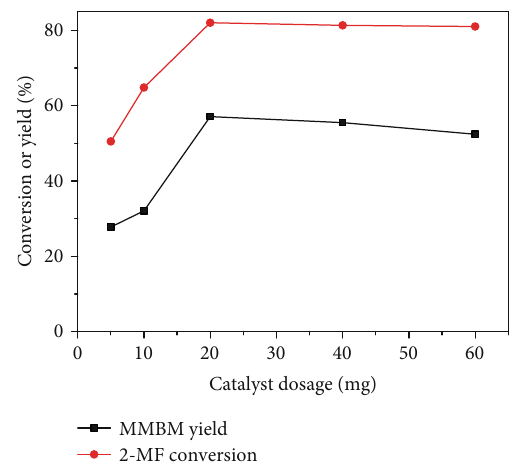
Figure 5: The in fl uence of the 3-BrPyPW catalyst dosage on the synthesis of MMBM from HMF and 2-MF. Reaction